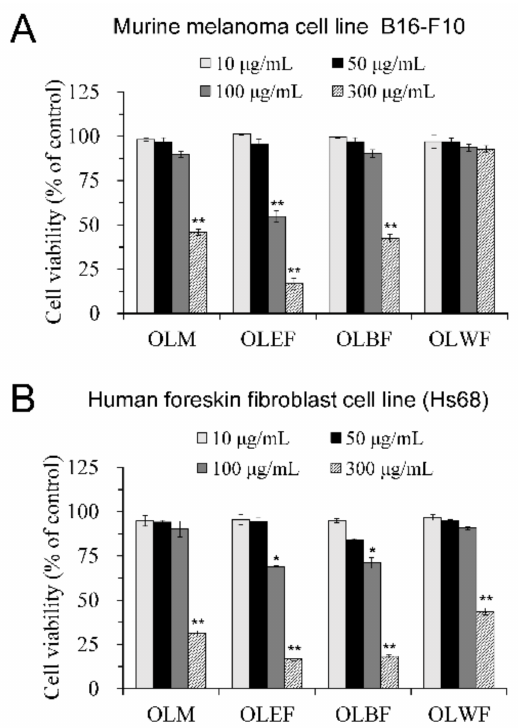
Figure 2. Effects of OLM and its different soluble fractions on the cell viability of B16-F10 melanoma ( A ) and Hs68 fibroblast cells ( B ). Cells were treated with vehicle control or 10–300 µ g/mL of OLM and its fractions, including ethyl acetate (OLEF), n -butanol (OLBF), and water (OLWF), for 48 h, with an XTT assay used to quantify their effects on cell viability. The cell viability was calculated as a percentage of the viability in control. Values are the mean ± SD of three independent experiments. * p < 0.05, ** p < 0.01, compared with the control